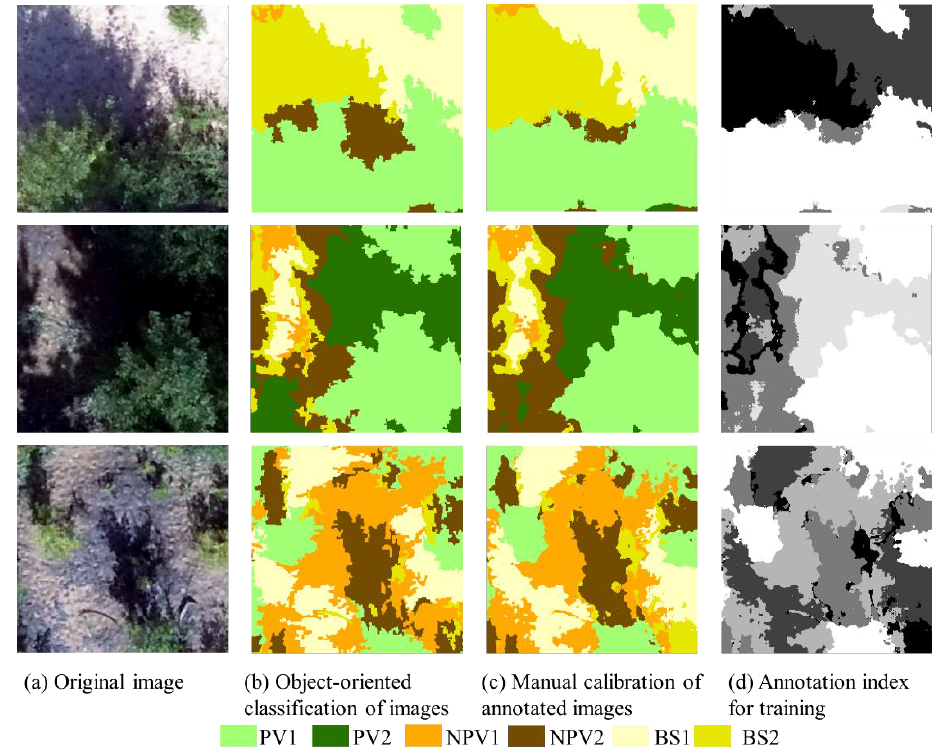
Figure 4. Object-oriented approach (combined with manual correction) for data annotation.